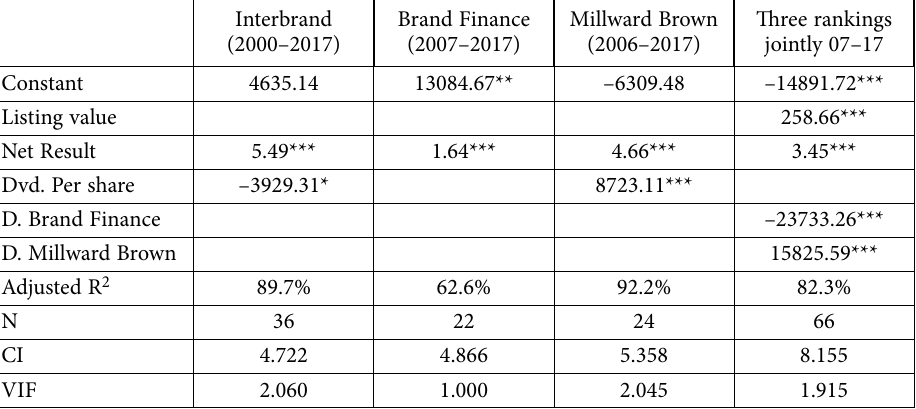
Table 9. The linear regression results for the high-value brands of the Information technology services